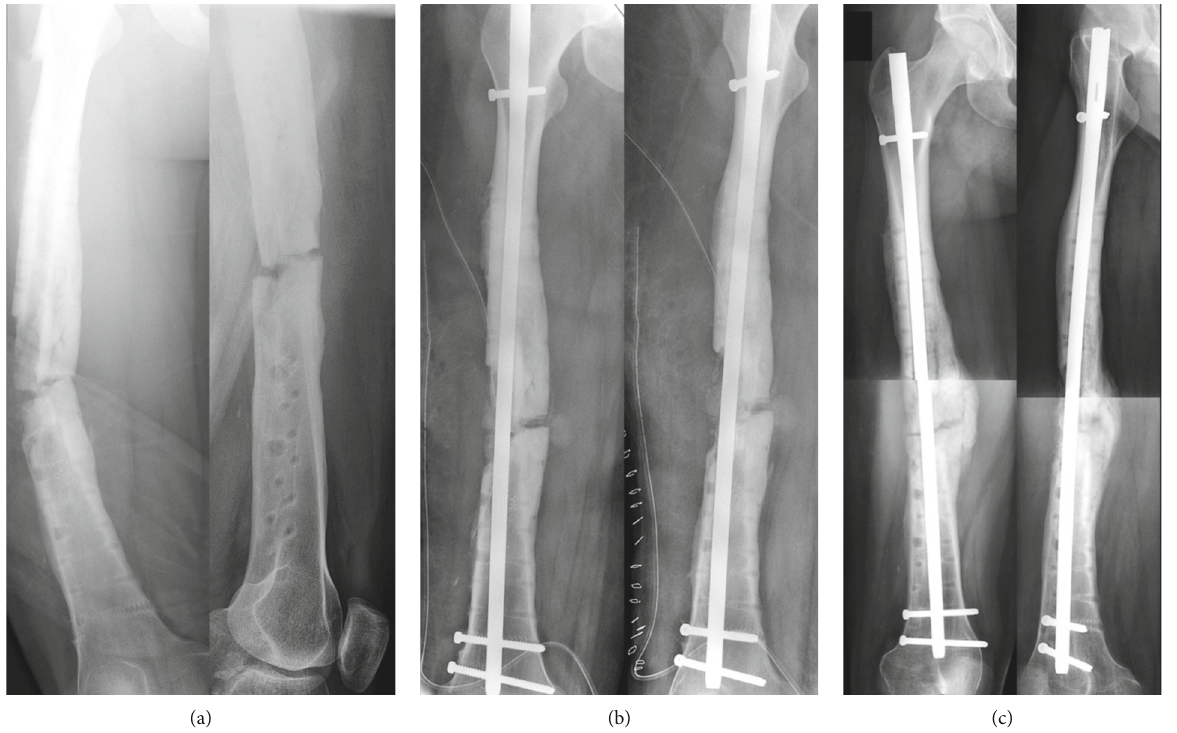
Figure 5: The patient presented an atraumatic fracture of the neoformed bone (a) after the removal of the implants 32 weeks after the bone healing. We opted for an intramedullary femoral nailing associated with a local autograft using the reaming debris (b). Complete bony union was achieved at 12 weeks of follow-up (c).